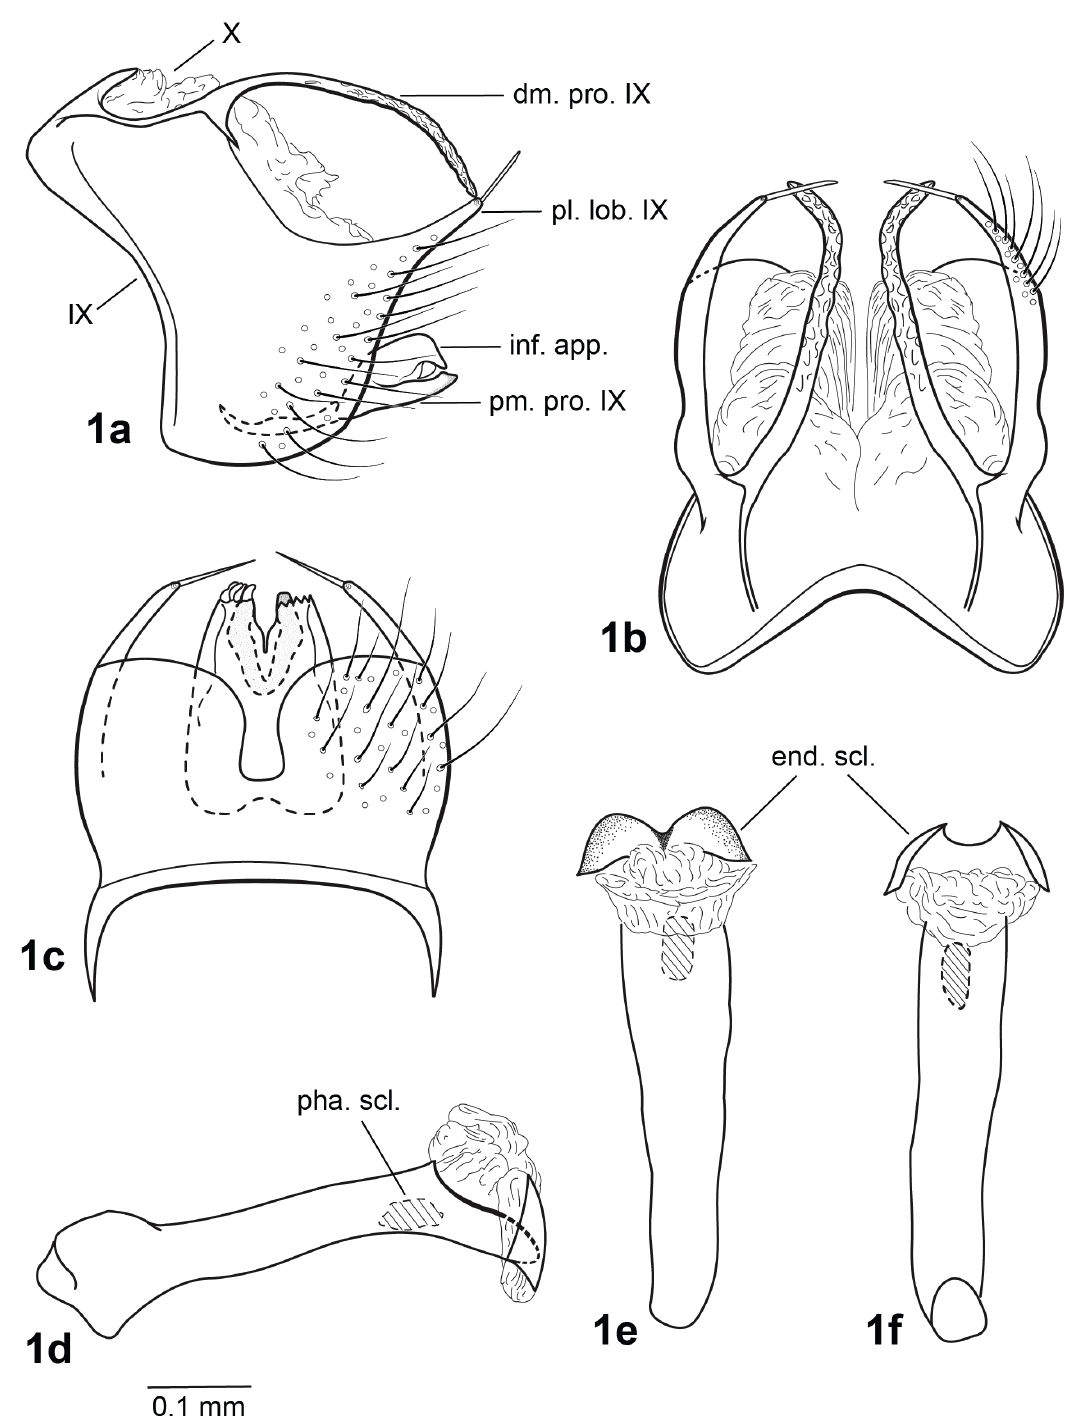
Figure 1 - Contulma vascaina sp. n., holotype male. 1a . Genitalia, left lateral; 1b . Genitalia, dorsal; 1c . Genitalia, ventral; 1d . Phallus, left lateral; 1e . Phallus, dorsal; 1f . Phallus, ventral. Abbreviations: IX - segment IX; X - tergum X; dm. pro. IX - dorsomesal process of segment IX; pl. lob. IX - posterolateral lobe of segment IX; inf. app. - inferior appendage; pm. pro. IX - posteromesal process of segment IX; phs. scl. - phallic sclerite; end. scl. - endothecal sclerites. Scale: 0.1